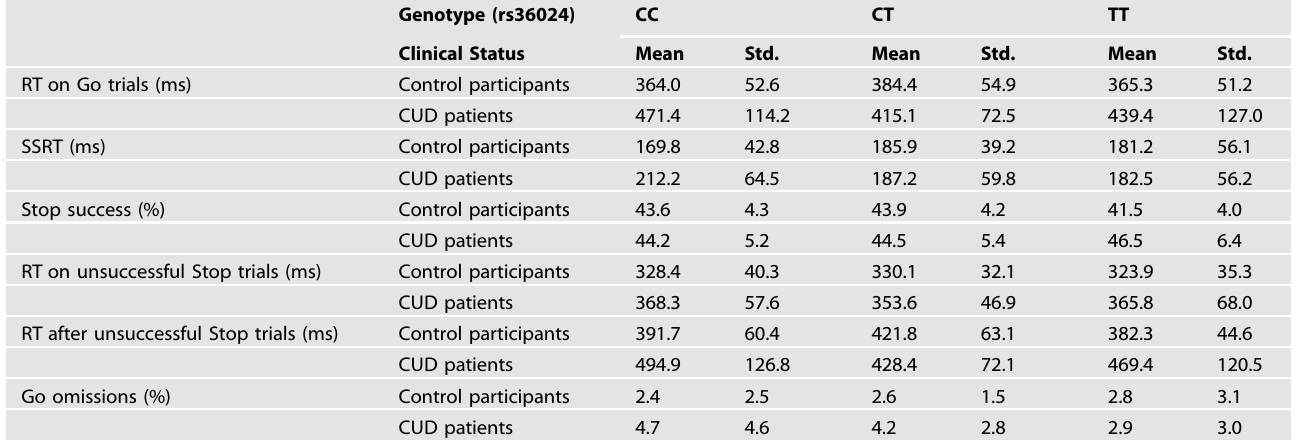
Table 2. Participant performance on the stop-signal task according to clinical group and genotype.